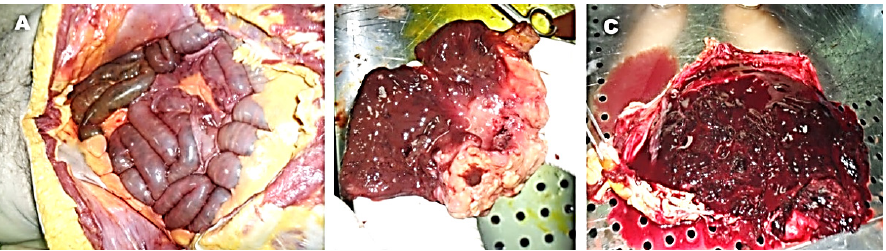
Figure 1. Autopsy findings. No fluid in the peritoneal cavity between the intestinal loops and no of macroscopic evident perforations ( A ). Macroscopic observation of the duodenum showed ulcerative lesion of the second portion with narrowing ( B ). The lumen of stomach was full of abundant blood clots ( C ).